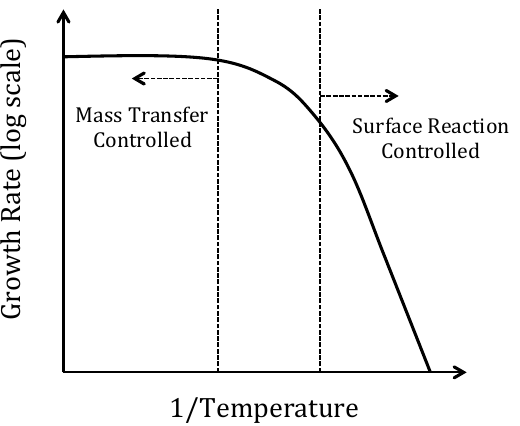
Figure A2. Relationship between the growth rate of the thin-film being deposited and the temperature (plotted as 1/temperature).